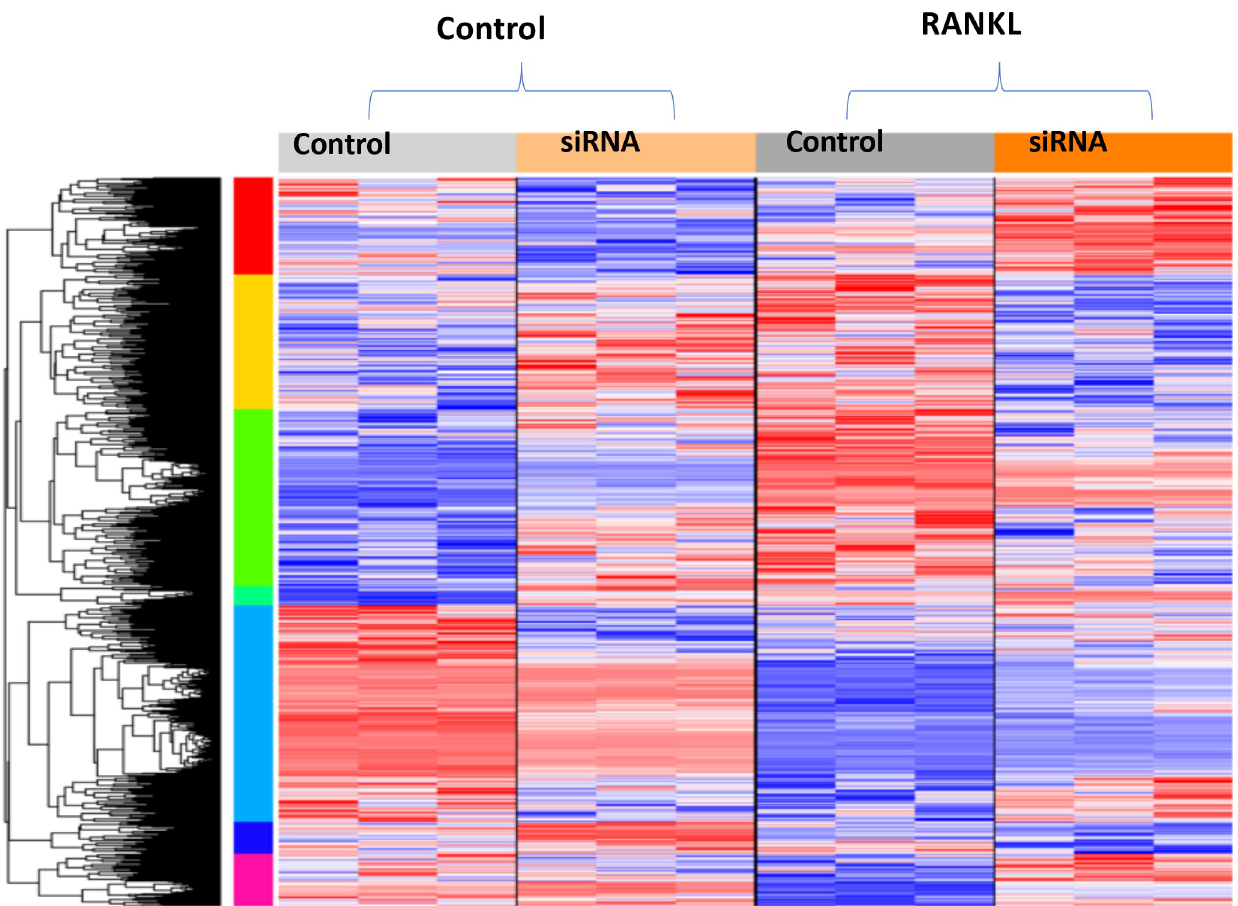
Fig 7. Profiling genes regulated by STAT3. Four groups of RAW264.7 cells: A) 1) unstimulated 2) +siRNA Stat3 unstimulated 3) stimulated with RANKL and 4) +siRNA Stat3 and stimulated with RANKL. Red–upregulated genes, Blue–downregulated genes. The list of genes regulated by RANKL and siRNA STAT3 is presented in S1 Data. The microarray data are also available at GEO (GES152986, https://www.ncbi.nlm.nih.gov/geo/query/acc.cgi?acc= GSE152986).